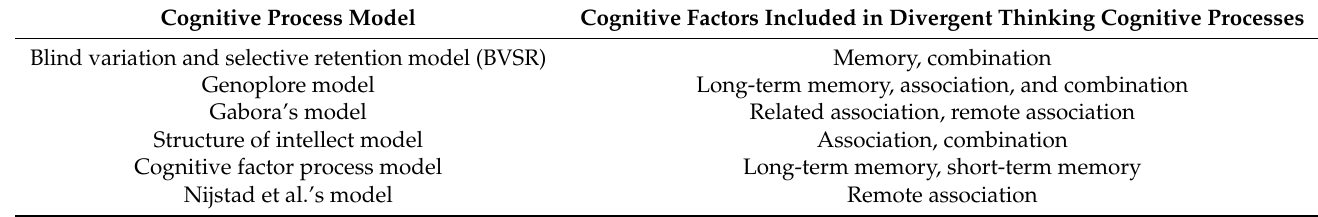
Table 1. Cognitive factors that are involved in the reviewed cognitive process